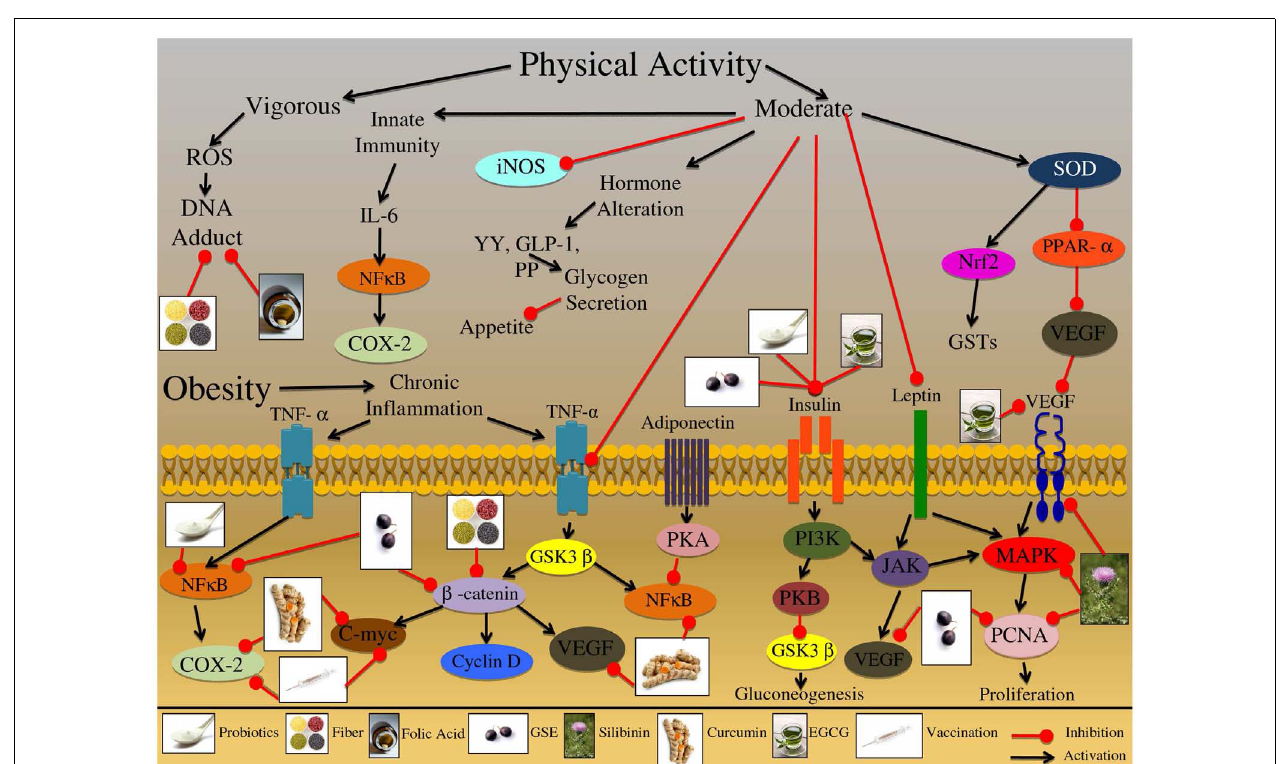
FIGURE 4 | Effect of physical activity and obesity on the growth and development of colon carcinogenesis .Vigorous physical activity had been shown to induce the production of reactive oxygen species (ROS) leading to DNA-adduct formation, potentially affecting the initiation of colorectal cancer (CRC). Alternatively, moderate physical exercise has been shown to induce an innate immune response through IL-6 receptor activation and downstream protein up regulation.This adaptive immune response protects the organisms against chronic inflammatory conditions, which are known to increase the risk of CRC development. Further, moderate physical activity has been shown to inhibit the expression of other inflammatory mediators, such as iNOS, which may play a role in chronic inflammatory conditions. Moderate physical activity has been also shown to alter specific hormones that are related to appetite and satiety signals; these hormones includeYY, GLP-1, and PP, all of which are involved in glycogen secretion. Practicing moderate physical activity also results in the up regulation of superoxide dismutase (SOD); this enzyme further activates detoxification pathways via up regulation of the Nrf2 proteins and GSTs enzymes. Additionally, SOD inhibits PPAR- α leading to the reduced expression ofVEGF, which is involved in the promotion and progression of CRC. Obesity is a result of an energy imbalance that results in aberrant activation of various receptor proteins involved in inflammation, proliferation, and hormone regulation.This abnormal activation creates an environment that is chronically inflamed and can result in the initiation, promotion and progression of CRC. One of the major inflammatory mediators isTNF- α , which is activated at the cell membrane, resulting in downstream protein